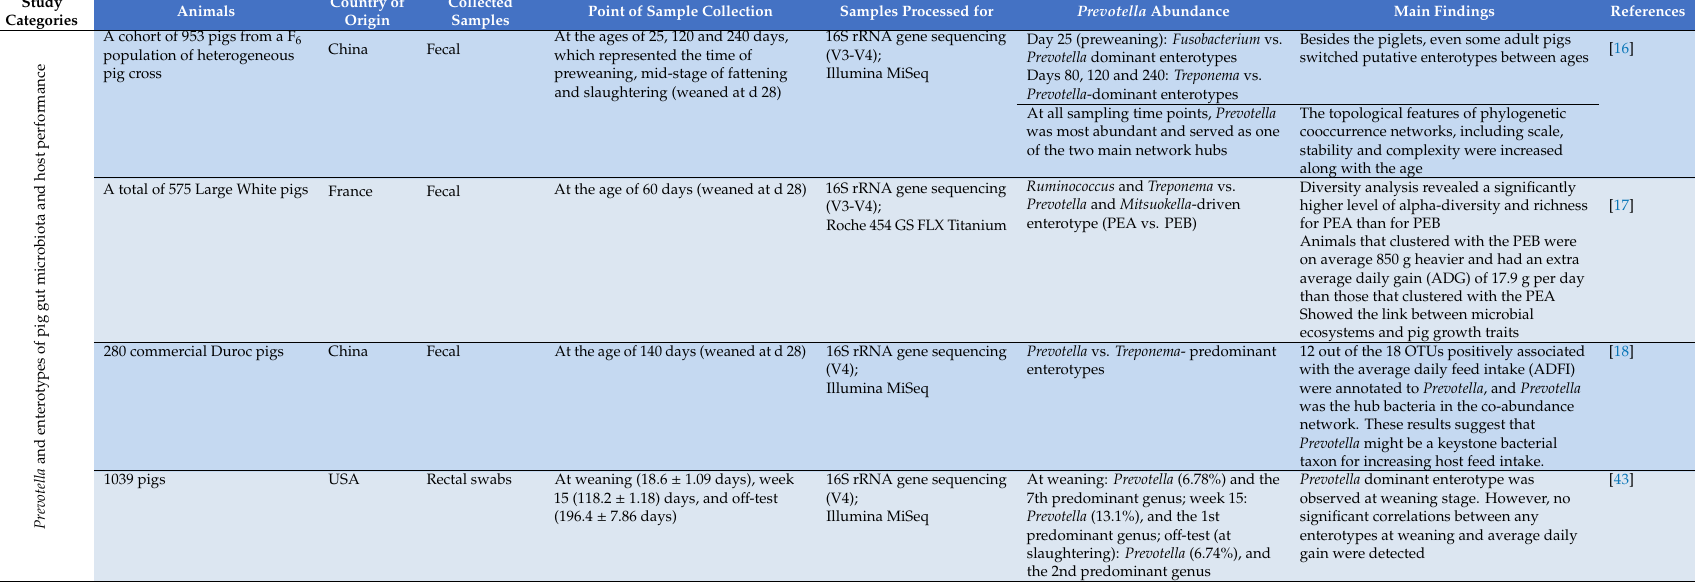
Table 2. The summary of studies (n = 11) showing the potential association of gut Prevotella with growth performance (positive) and diarrhea (negative) in pigs (determined by high throughput sequencing